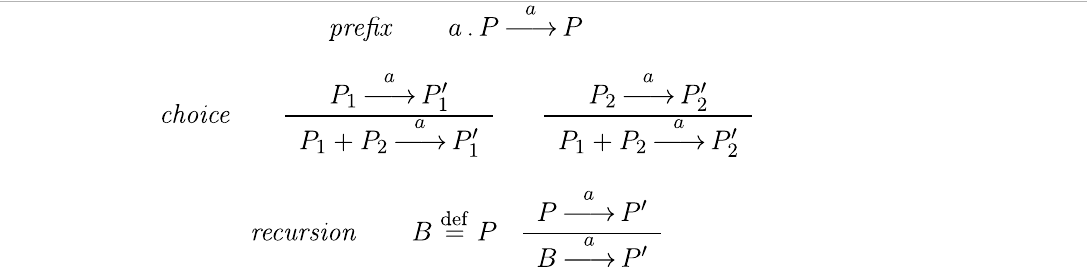
TABLE 1 | Semantics rules of the basic